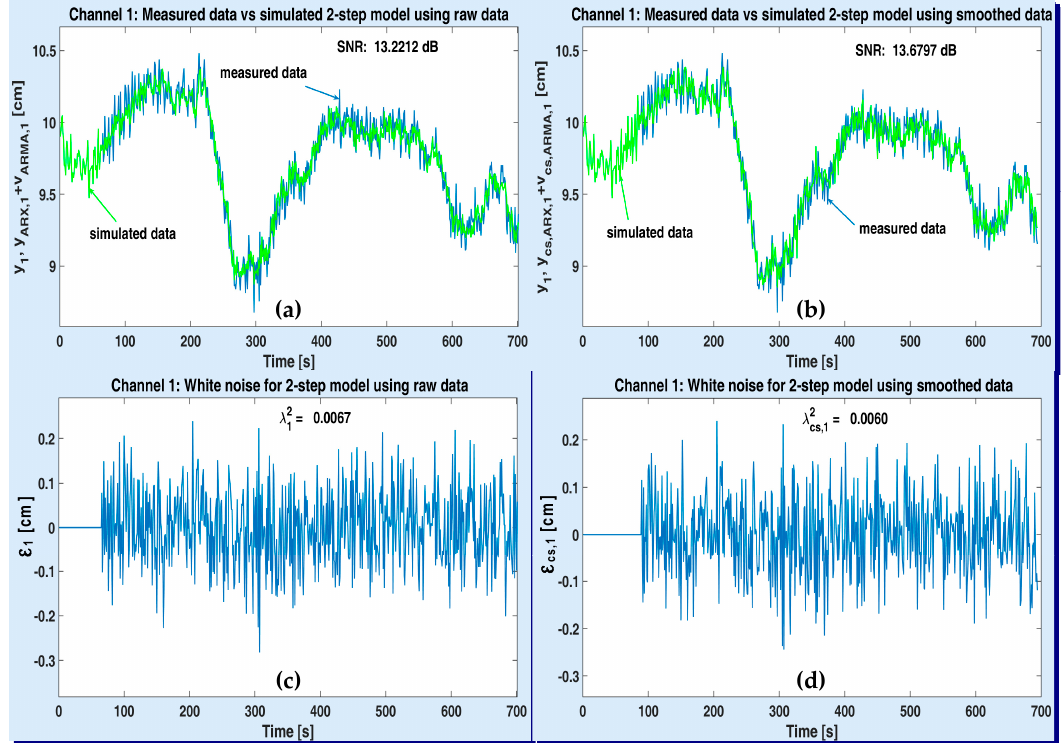
Figure 11. Performance of the optimal 2-step MISO model associated to ASTANK2 installation, on channel 1: measured versus simulated outputs with raw data ( a ) and smoothed data ( b ); estimated white noise from raw data ( c ) and smoothed data ( d ).